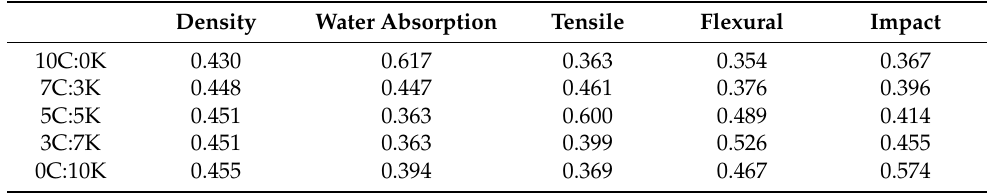
Table 7. The normalized matrix.